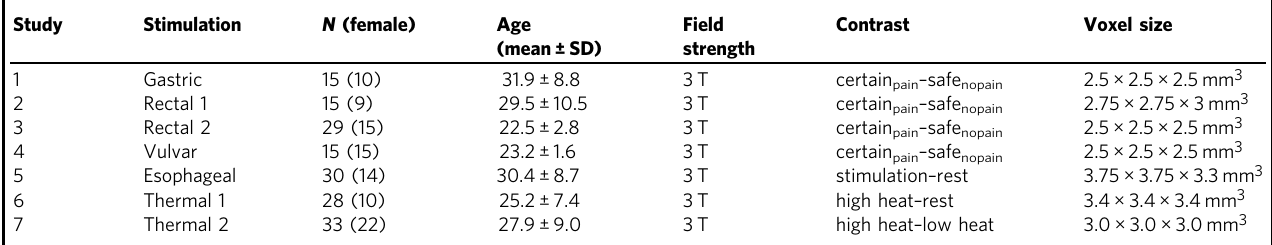
Table 1 Summary of studies. All studies modeled activity during painful/uncomfortable stimulation periods.